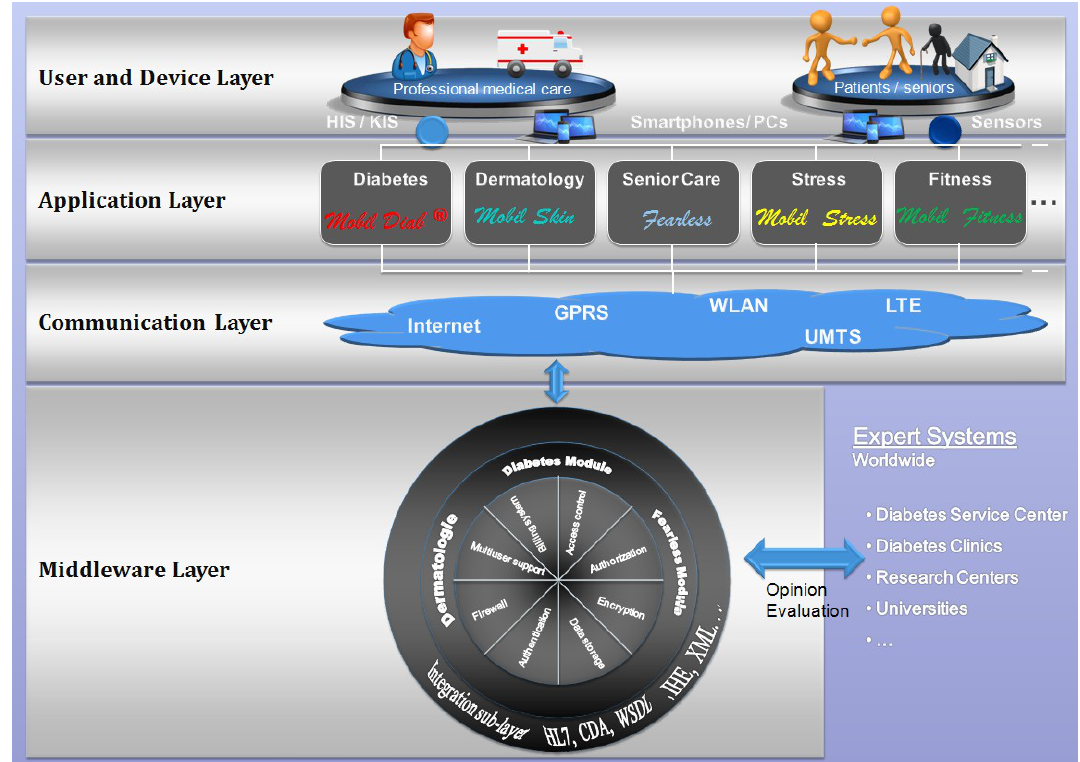
Figure 3. Architecture of the ―Mobil Diab‖